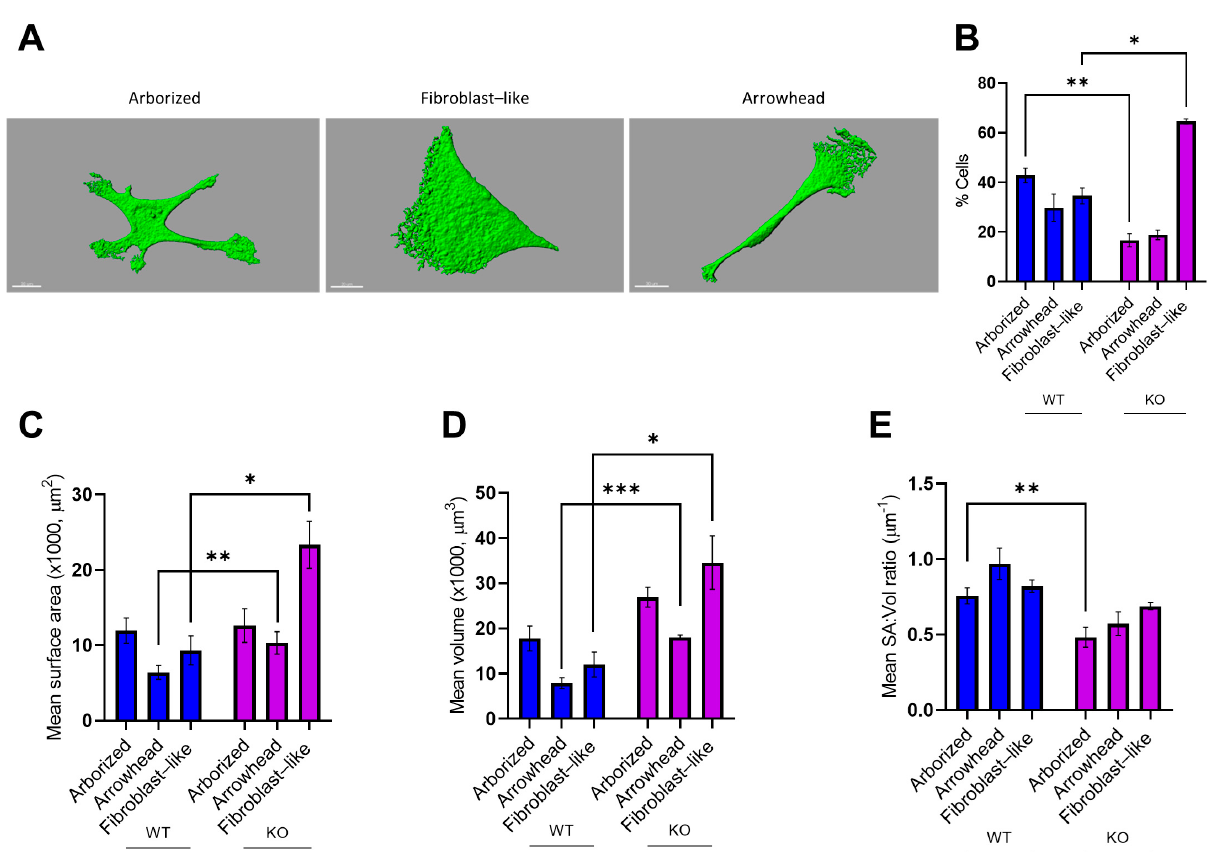
Figure 5. MT5-MMP-deficient astrocyte-like cells display morphological changes. ( A ) Representative images obtained with 3D IsoSurface reconstruction from serial confocal z-stacks of GFAP-stained astrocytes, showing clear differences in morphology, were binned into three categories: arborized, fibroblast-like, and arrowhead. ( B ) Bar chart showing the percentage of cells belonging to each of the three morphotypes from wild-type and MT5-MMP knockout (KO) astrocyte cultures. Note that MT5-MMP KO cultures showed a greater proportion of fibroblast-like astrocytes at the expense of arborized astrocytes (two-way ANOVA with Sidak´s post hoc test, N = 3 culture preparations, n = 245 GFAP+ astrocytes, F (2, 239) = 7.72, ** p < 0.01; * p < 0.05). ( C – E ) Bar charts depicting the comparative quantification of astrocyte-like cell surface area (nested t-test, N = 3, n = 73; arborized, n = 33, F = 0.013, p = 0.92; arrowhead, n = 24, F = 12.5, ** p = 0.002; fibroblast-like, n = 16, F = 13.8, * p = 0.02, in ( C ), volume (nested t-test, N = 3, n = 73; arborized: n = 33, F = 3.55, p = 0.13; arrowhead: n = 24, F = 13.8, *** p < 0.001; fibroblast-like: n = 16, F = 8.98, p = 0.04, in ( D ) and SA:Vol ratio (nested t-test, N = 3, n = 73; arborized: n = 33, F = 9.60, ** p = 0.004; arrowhead: n = 24, F = 4.75, p = 0.09; fibroblast-like: n = 16, F = 4.08, p = 0.06, in ( E ) between the different genotypes. Data are presented as mean ± SEM.